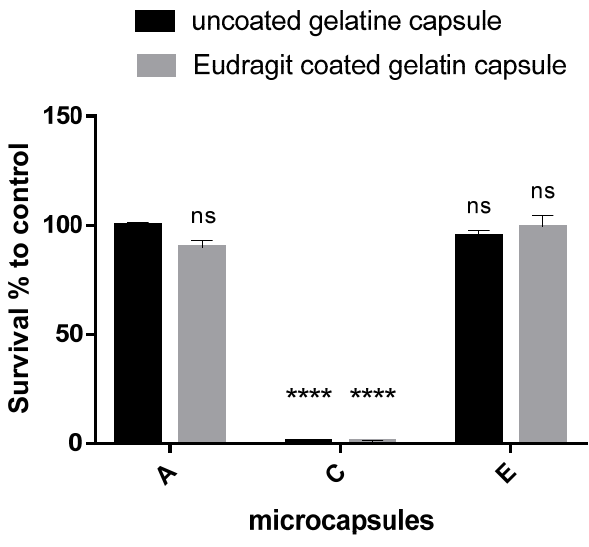
Figure 4. Elemental spectrum of uncoated alginate ( a ), chitosan-coated ( b ), and Eudragit L100-55- coated ( c ) microcapsule surface.